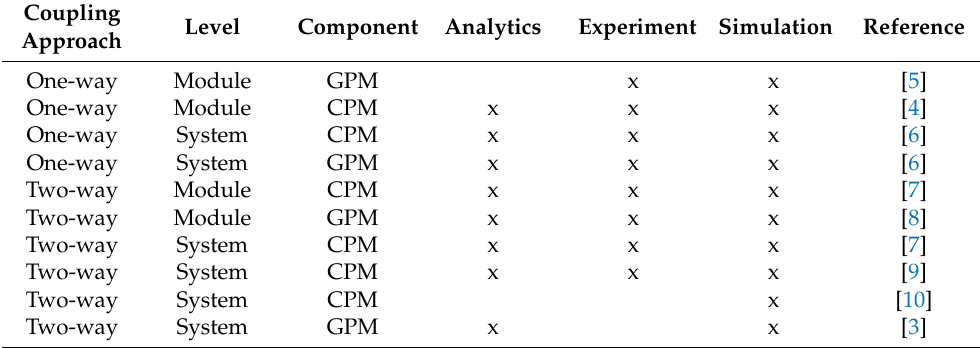
Table 1. Overview of existing research on coupled simulation approaches for predicting the electromagnetic–thermal behavior of wireless power transfer